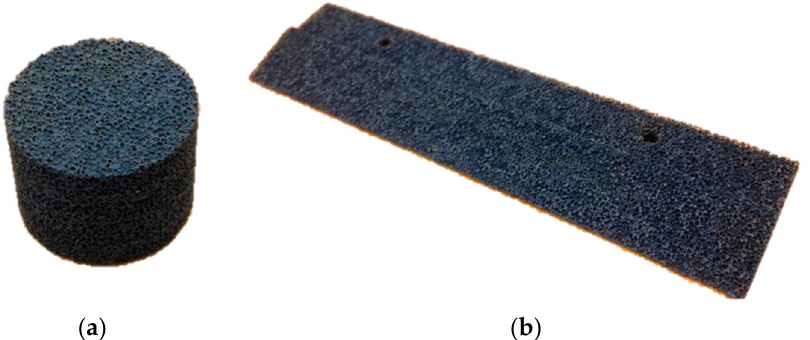
Figure 1. Examples of ( a ) cylinder of 2 cm diameter, and ( b ) trailing edge insert of 14 cm length manufactured by water-cutting of 1200 μ m permeable foam.